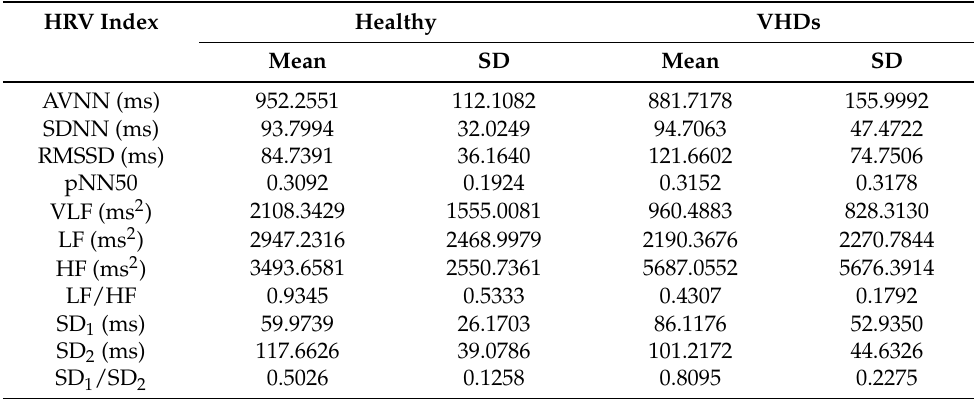
Table 2. HRV indices derived from ECG signals from both datasets.